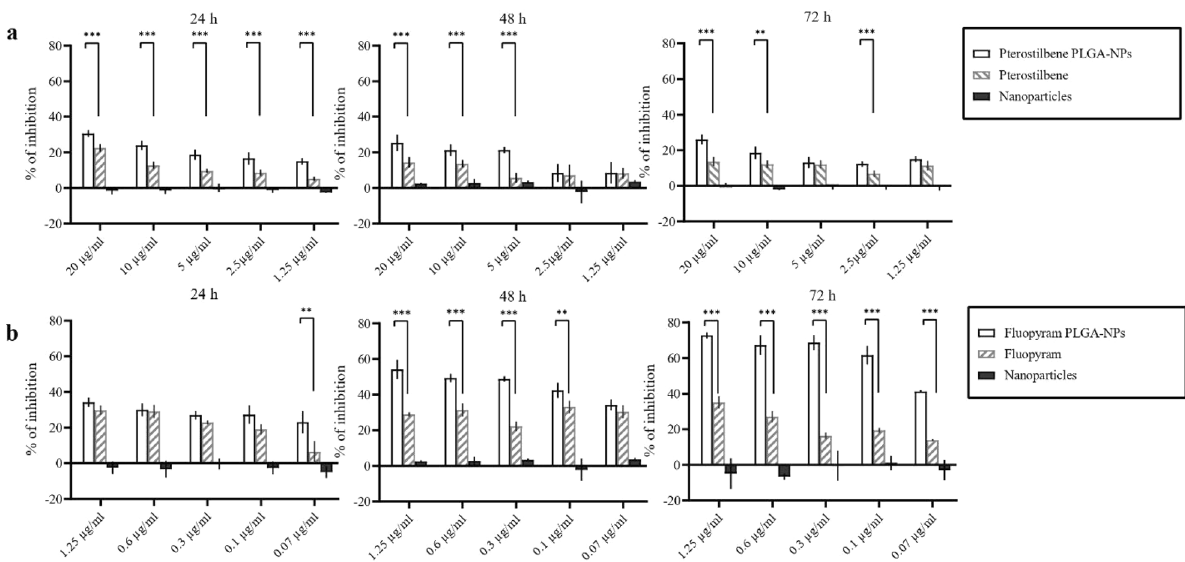
Figure 5. Activity of pterostilbene and fluopyram, free or loaded in PLGA NPs, against 12 h -germinated conidia of Botrytis cinerea DSM 877 after 24, 48, and 72 h of incubation. * P ˂ 0.05, ** P ˂ 0.01, *** P ˂